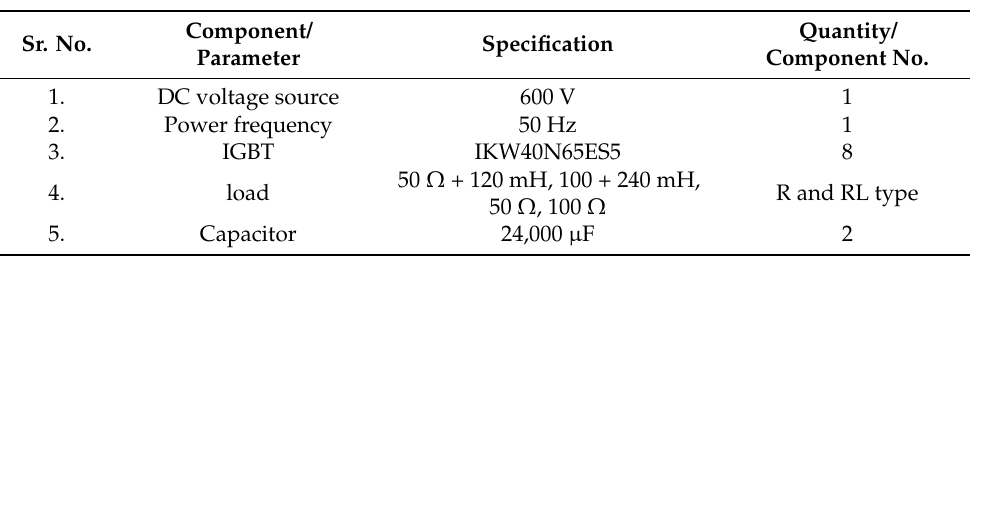
Table 3. MATLAB parameter